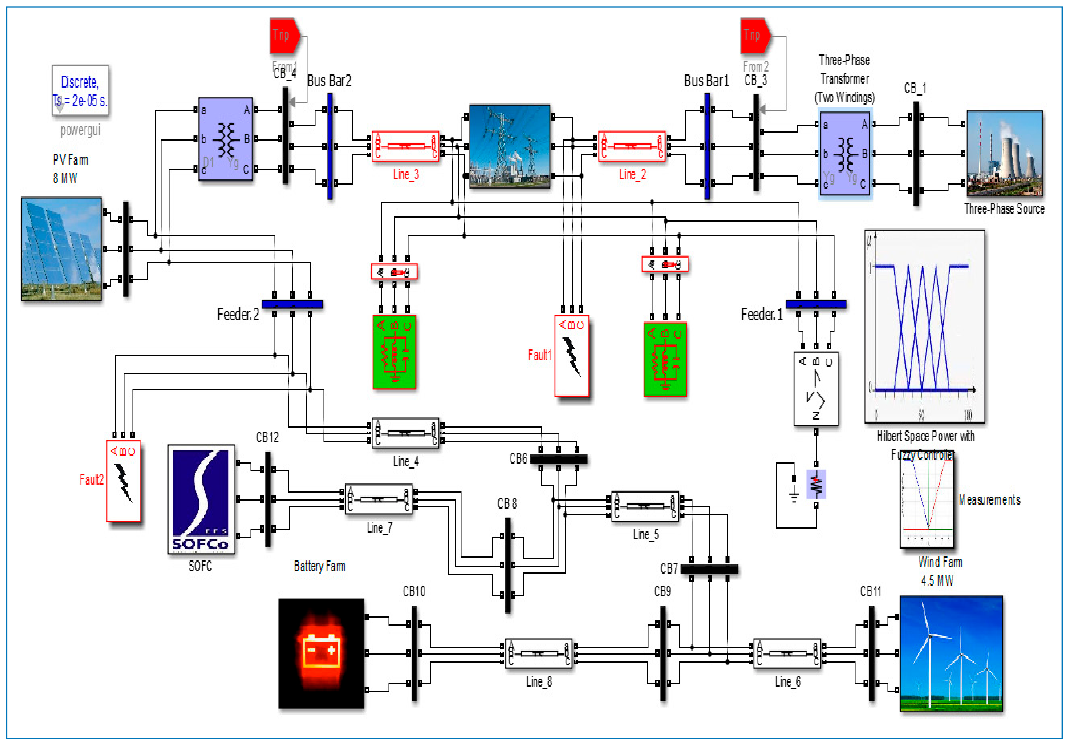
Figure 2. Developed microgrid model in SIMULINK.